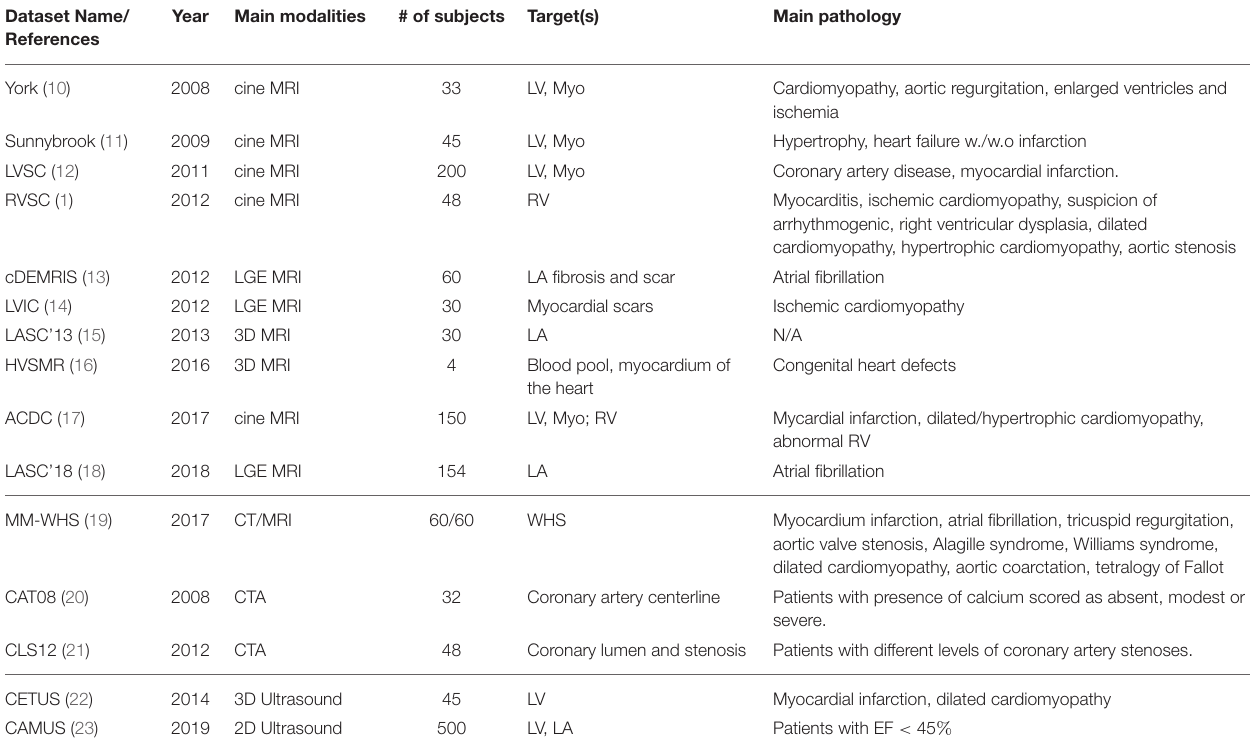
TABLE 6 | Summary of public datasets on cardiac segmentation for the three